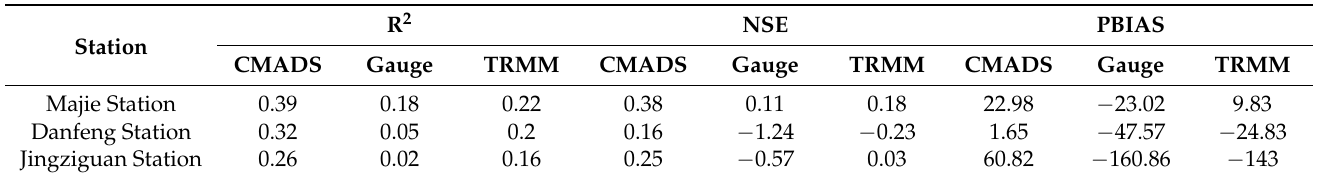
Table 5. The pre-calibration performance error amounts of the SWAT model simulated with CMADS, TRMM, and Gauge data on the daily